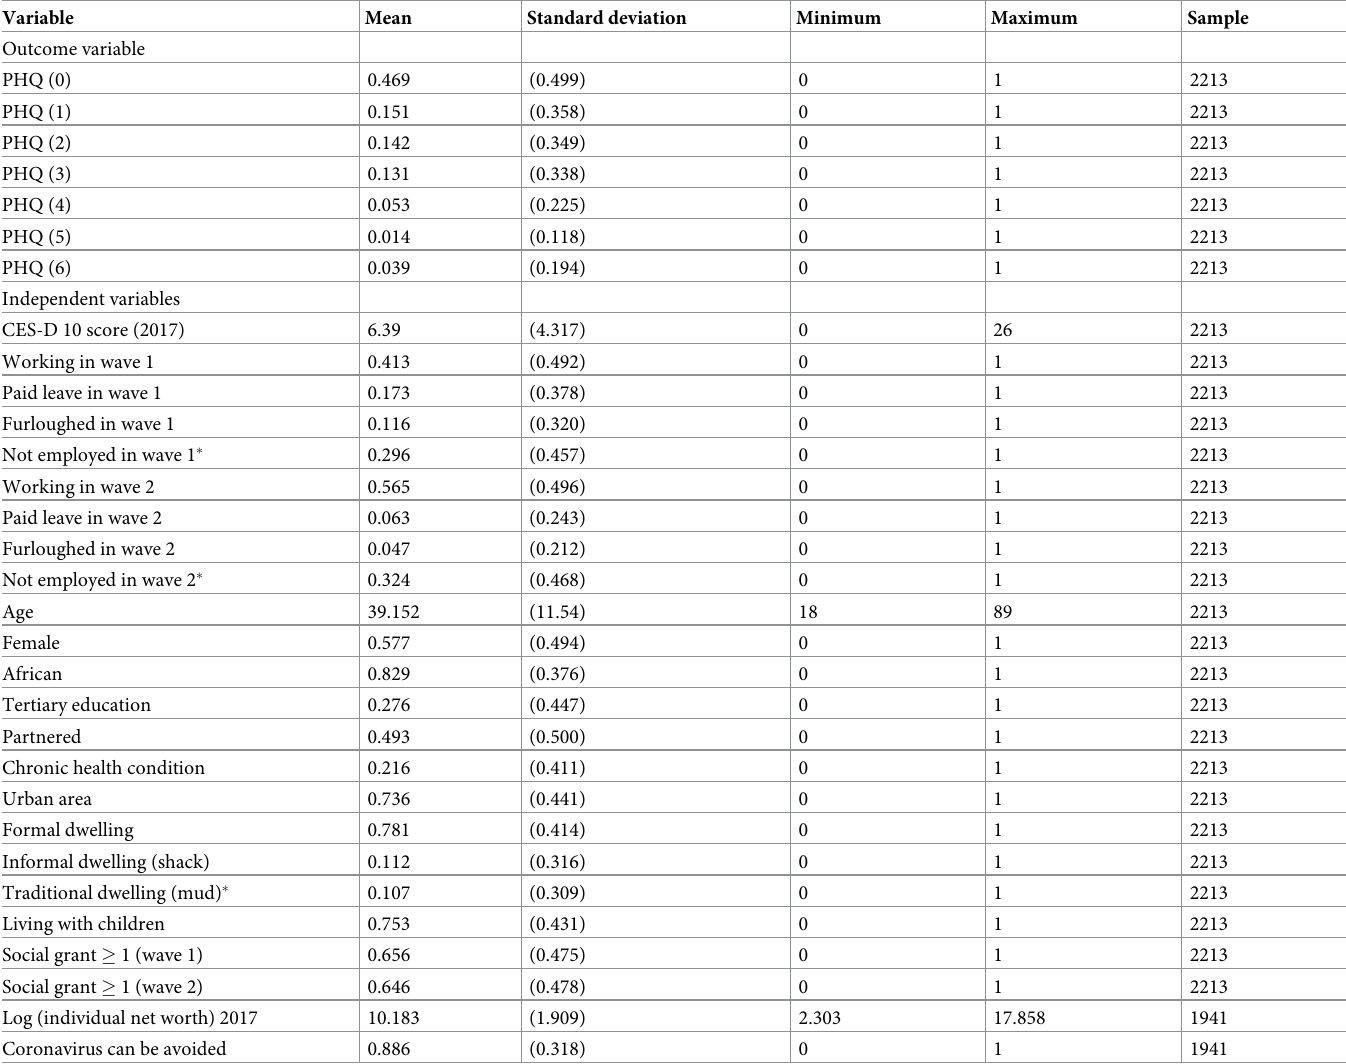
Table 1. Descriptive statistics of adults who were employed before the